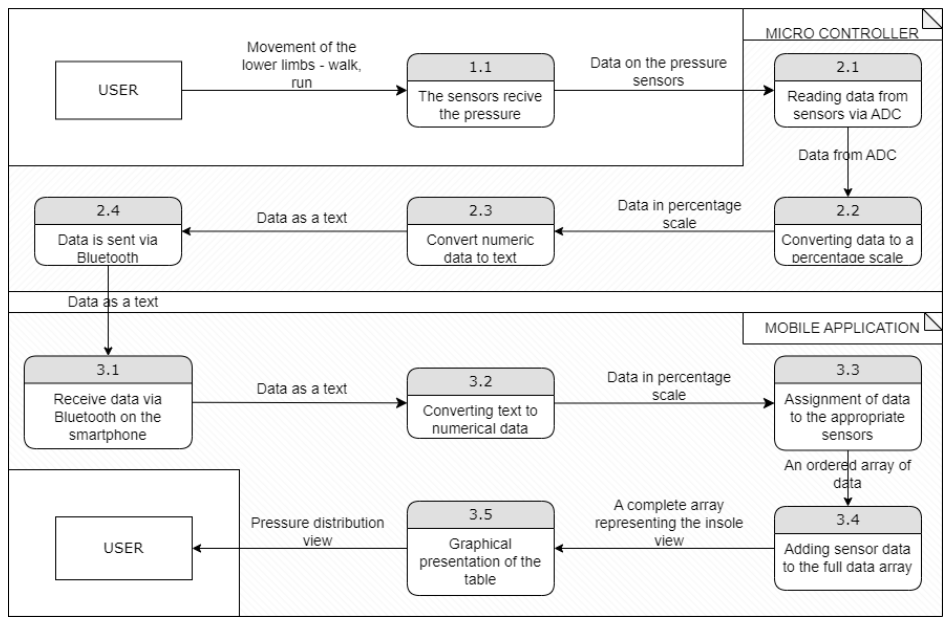
Figure 8. Data flow diagram of data in the